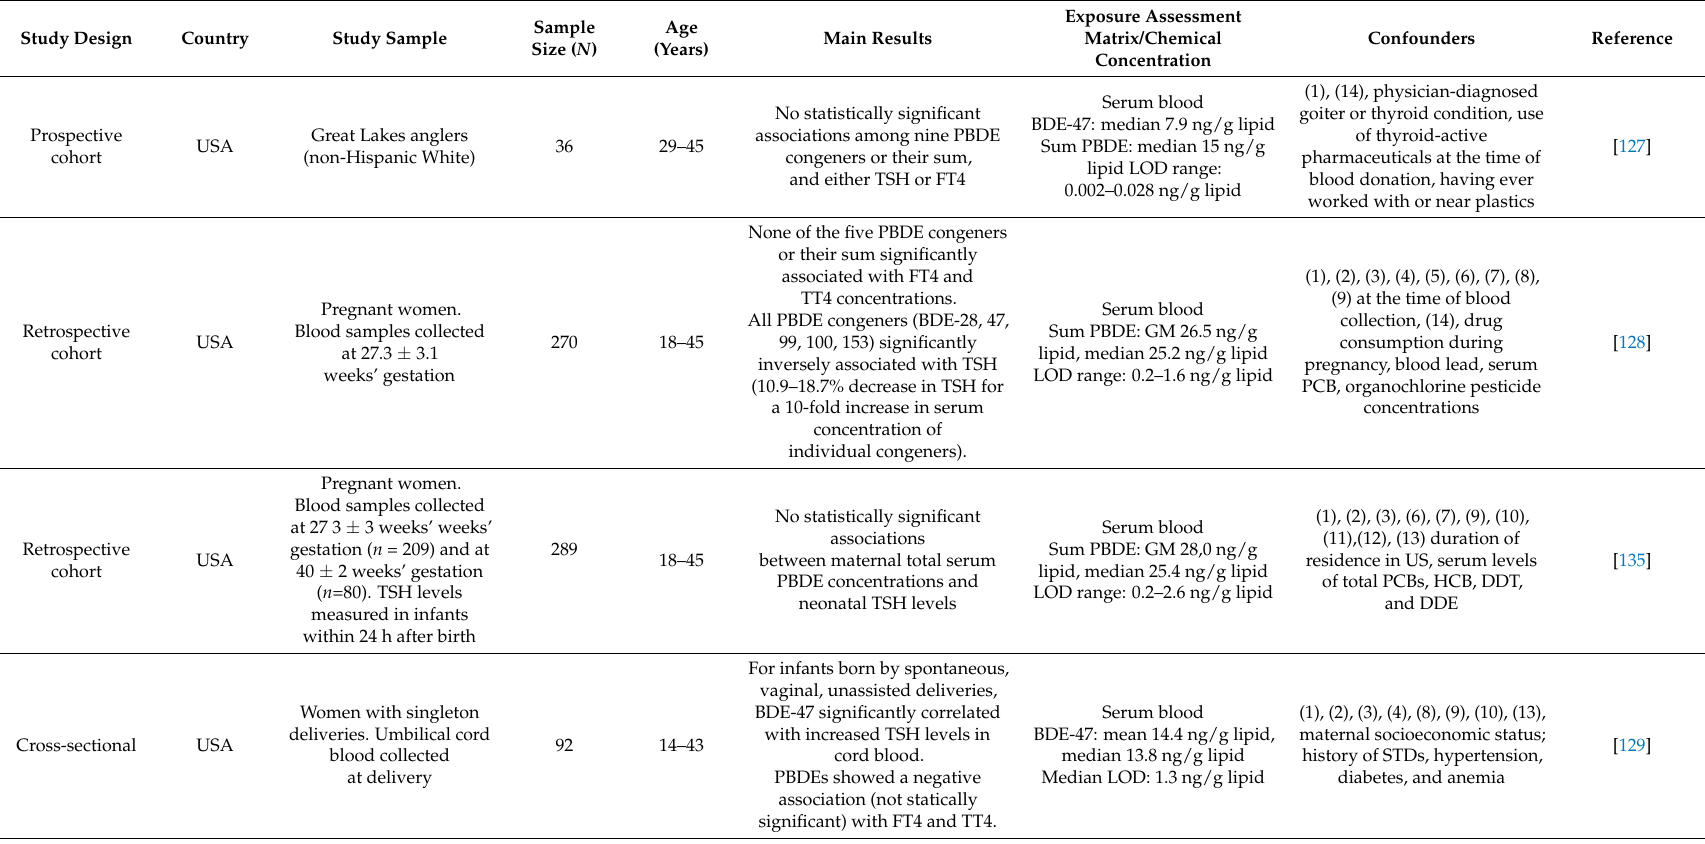
Table 2. Summary of human studies on association between PBDE exposure and thyroid